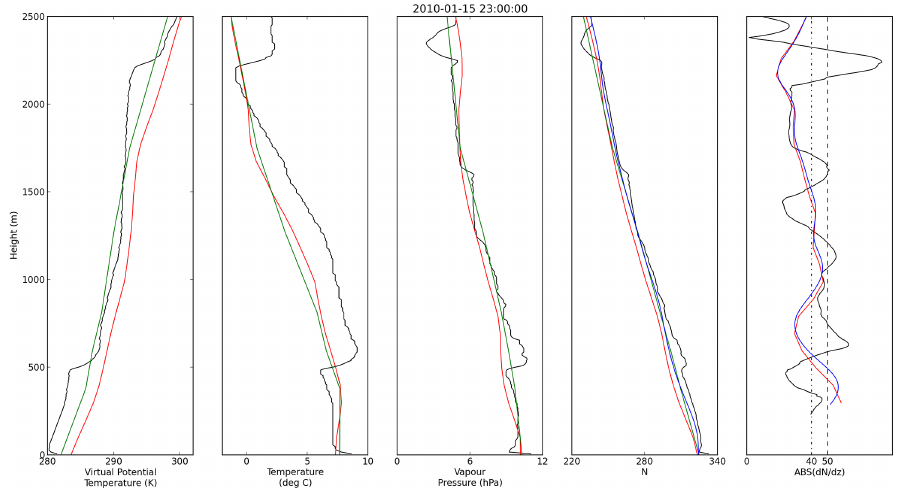
Figure 4. Profiles for 15 January 2010 at 23Z for MAC (black), COSMIC wet (red), COSMIC raw (blue), and ECMWF (green). Vertical dashed (dash-dotted) line represents the threshold defining main (secondary) break point.